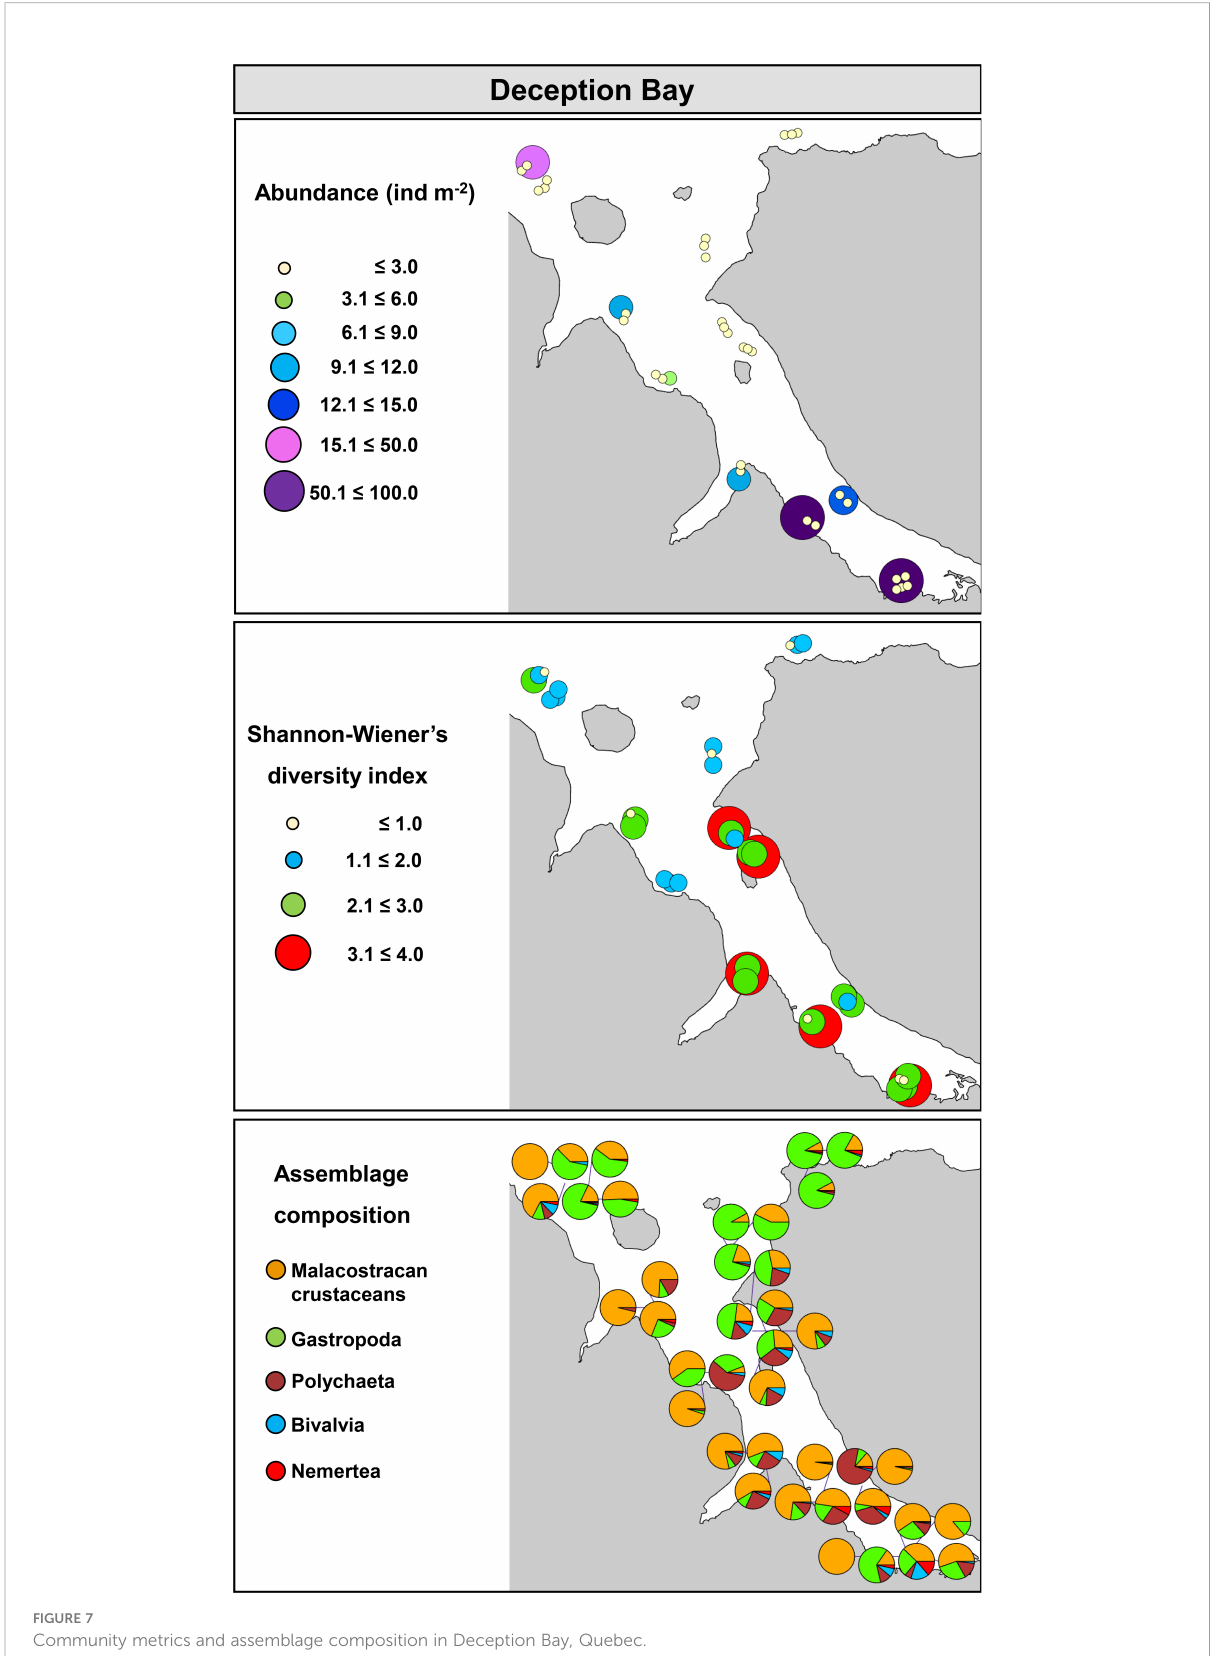
FIGURE 7 Community metrics and assemblage composition in Deception Bay,